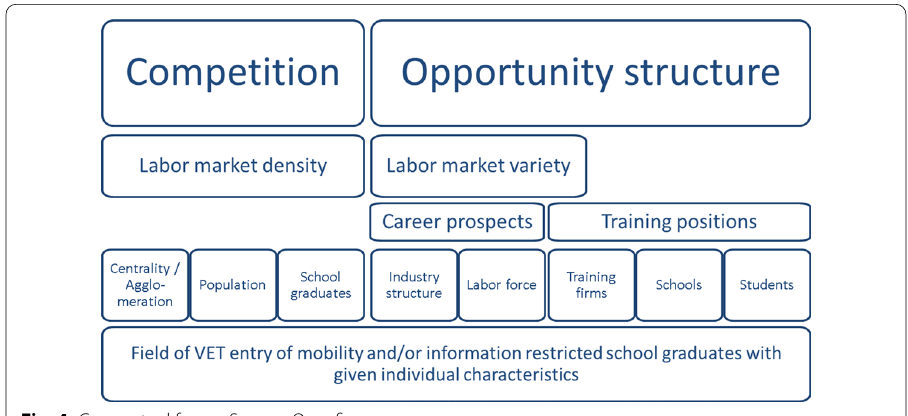
Fig. 4 Conceptual frame. Source: Own